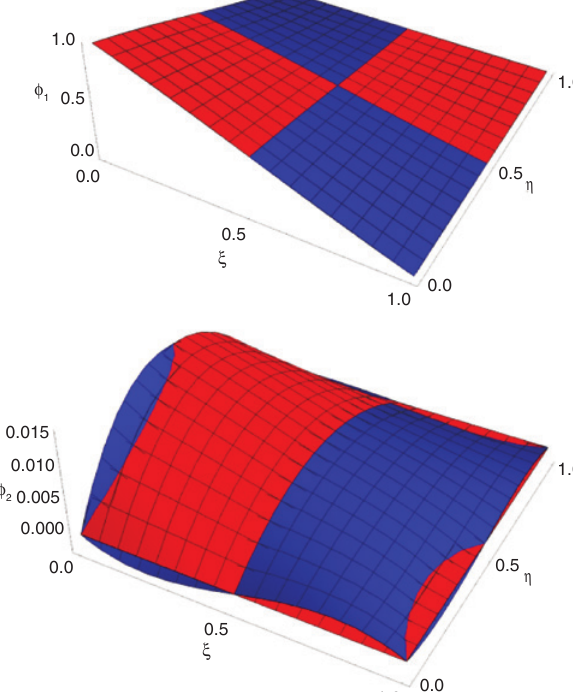
Figure 3: The first two deflection shape functions, a / b = 1, h / b = 1.6: red – conforming element, blue – non-conforming